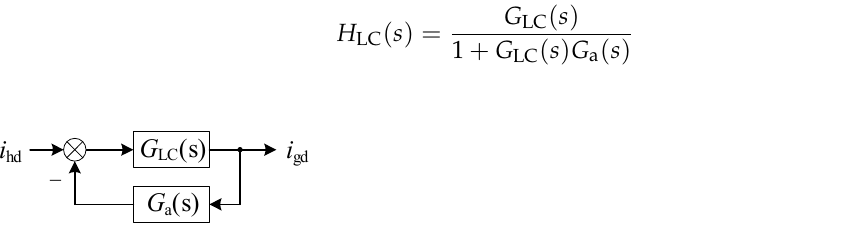
Figure 7. Frequency responses of the transfer function of the grid current control. The curve with K a = 0 is for the G LC ( s ) without additional damping control. The other curves are for the H LC ( s ) with the proposed active damping control.